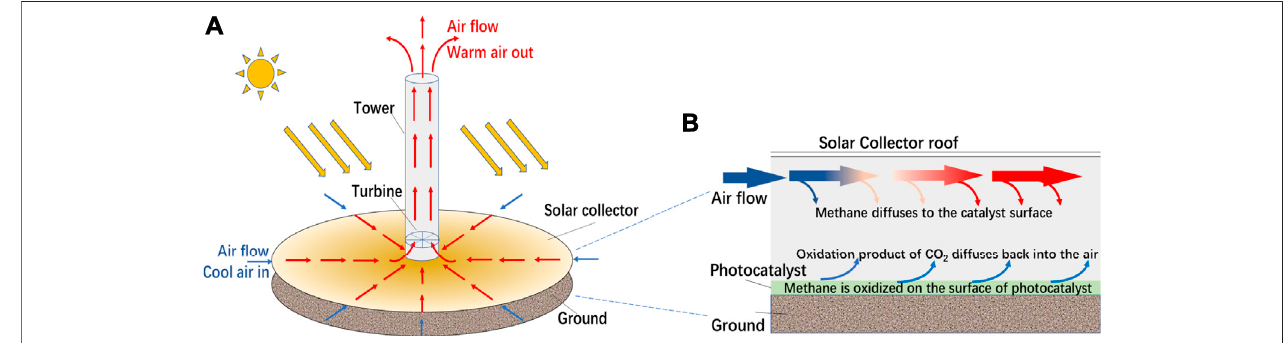
FIGURE 1 | (A) The structure of SUT, (B) a conceptual diagram of the integrated system for methane removal through SUT.